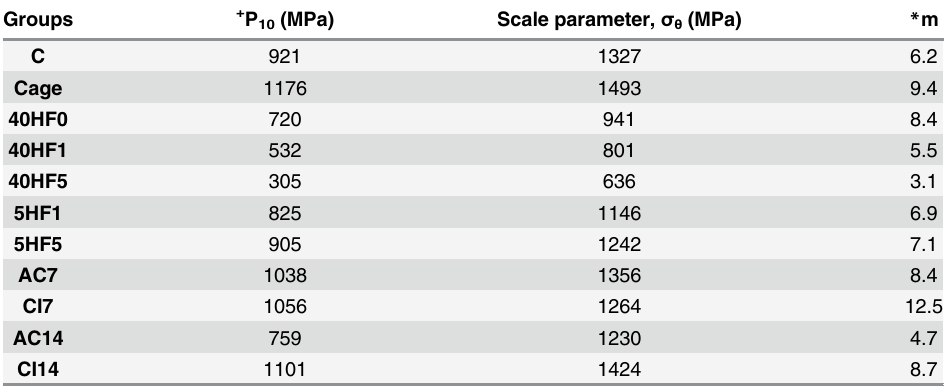
Table 3. Weibull statistics determining a 10% probability of fracture (P10) derived from the flexural strength values.